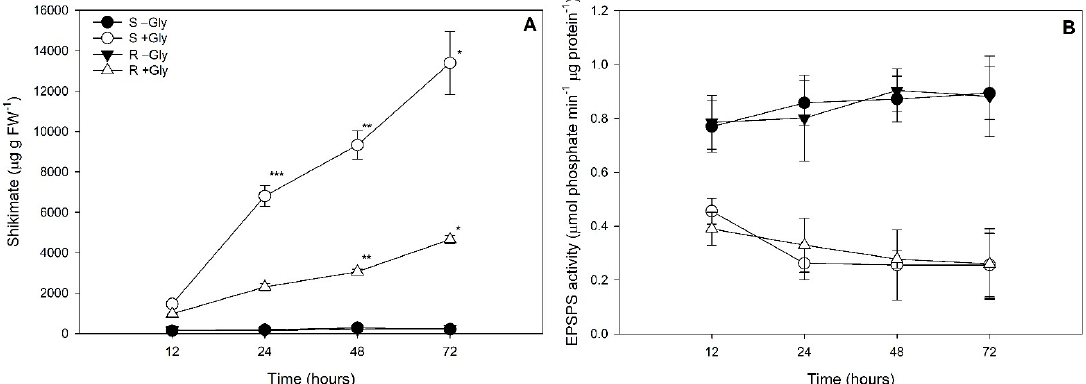
Figure 2. Shikimate concentrations ( A ) and 5-enolpyruvylshikimate-3-phosphate synthase activities ( B ) in glyphosate susceptible (S) and resistant (R) Conyza spp. plants exposed to 0 (-Gly) or 1080 g glyphosate (a.e.) ha − 1 (+Gly) for 72 h. Values are represented as the mean ± standard error of five replicates. * , ** , *** indicates significant differences between times with the same biotype and glyphosate concentrations, by the Contrast test (considering p < 0.05).